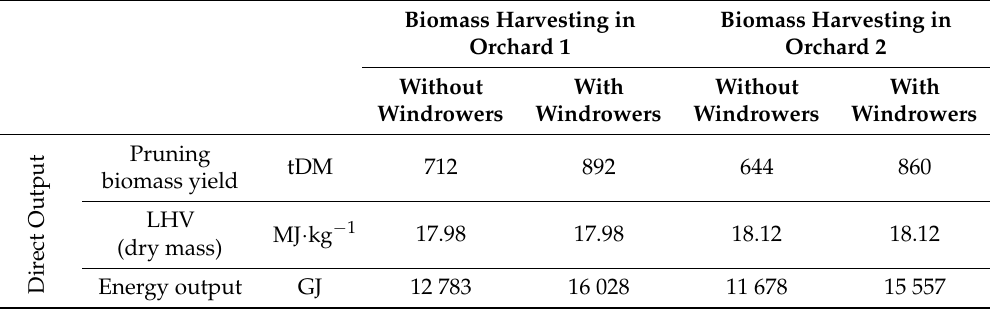
Table 4. Direct energetic output for evaluated pruned biomass harvesting variants in the apple orchards (operated orchard area 400